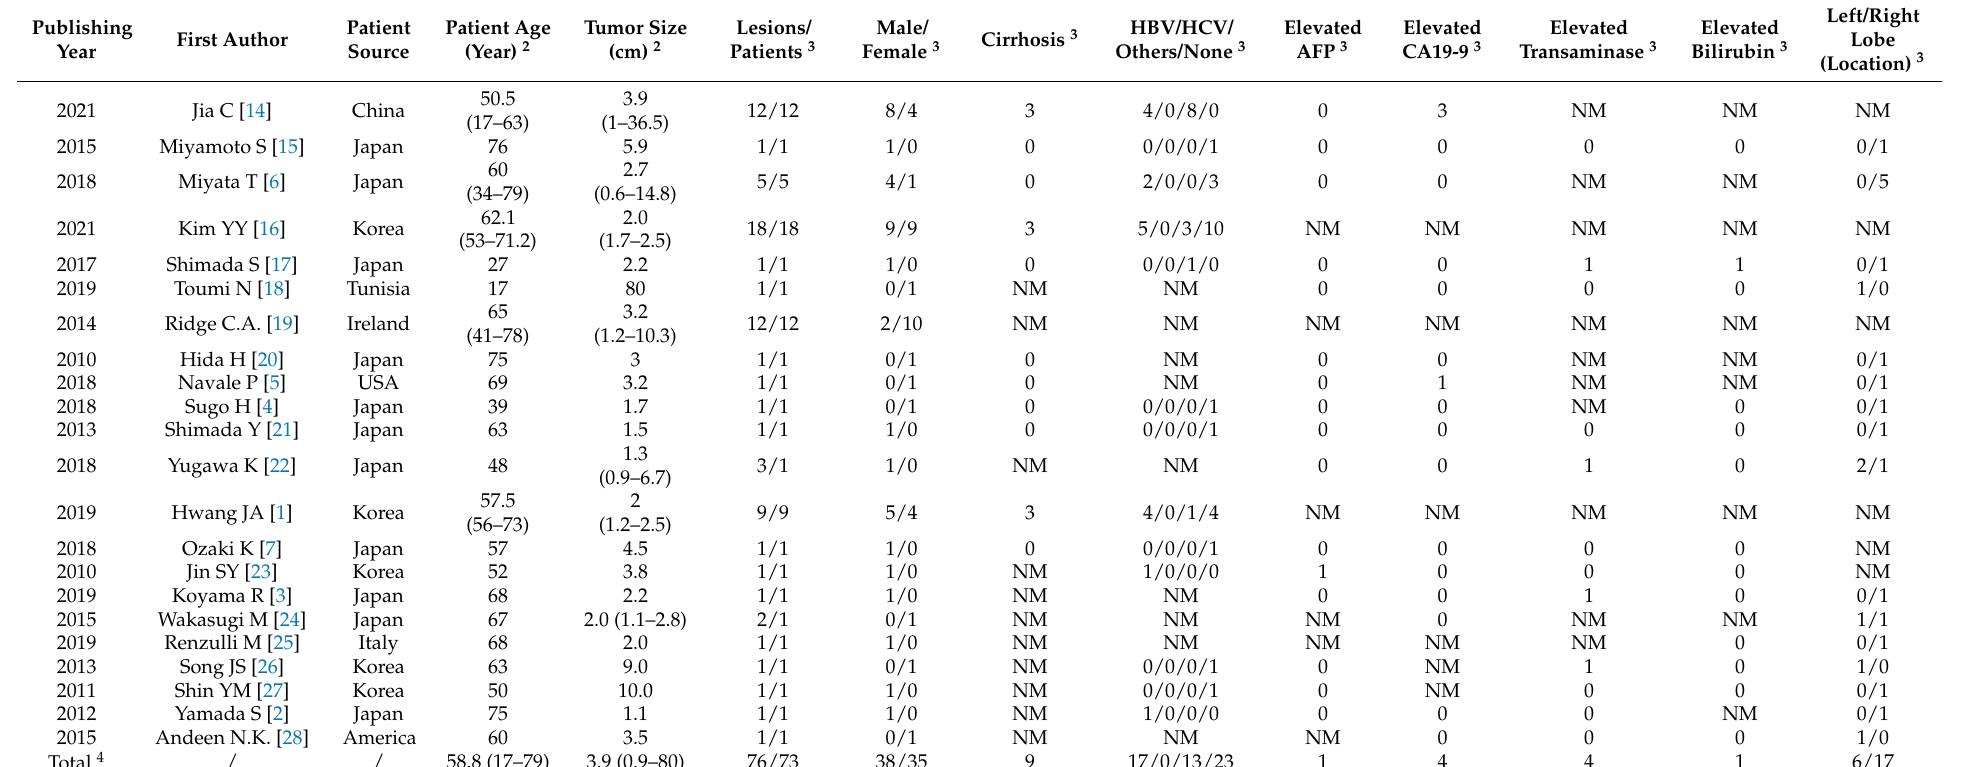
Table 2. Review of clinical features for HSH 1